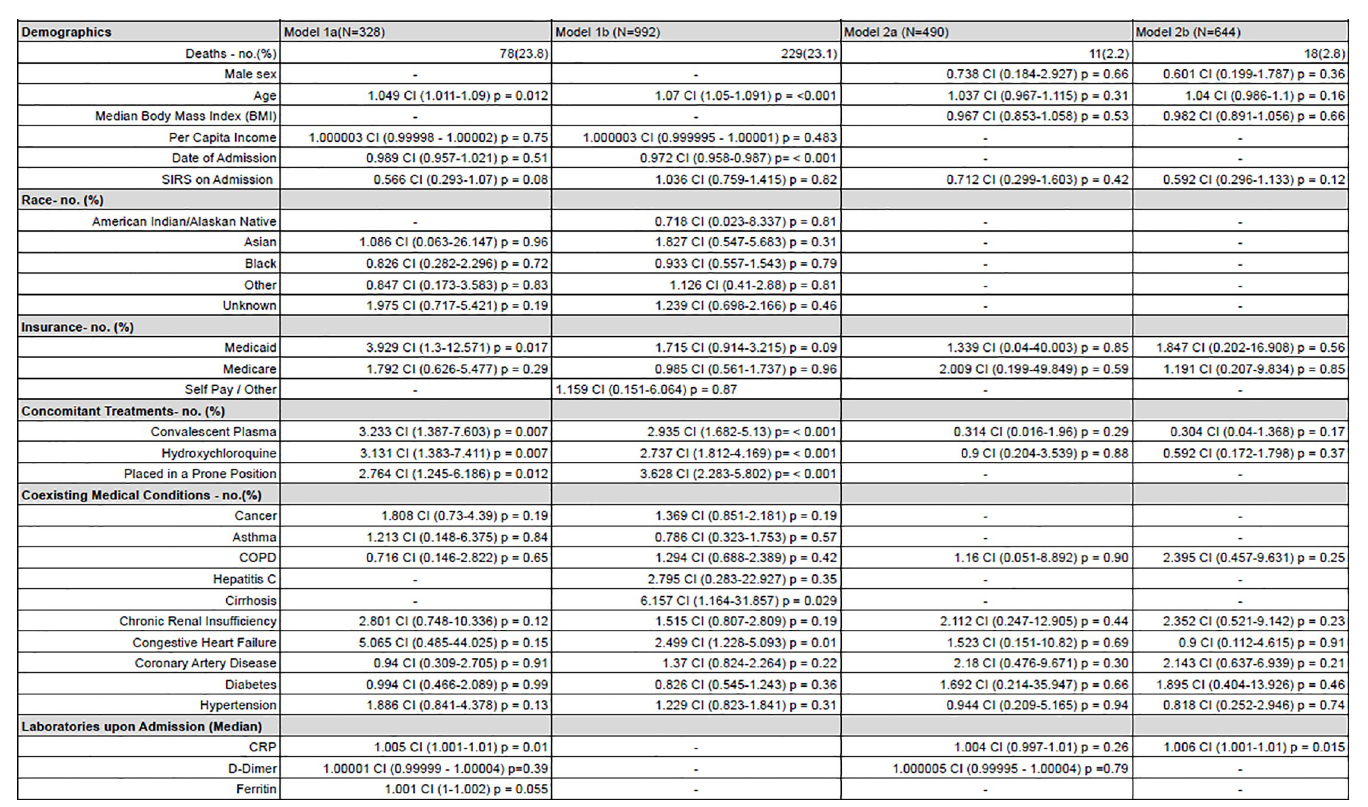
Fig 3. Odds ratios for inpatient mortality. (A) Odds ratios for mortality were determined through binomial logistic regression and are presented with 95 percent confidence intervals. Variables controlled for in the models are included in this table. For race, odds ratios were calculated against those self-reporting as Caucasian, and for insurance, those with commercial